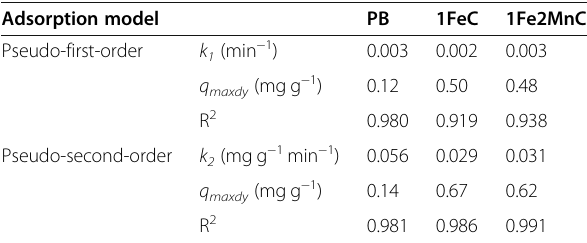
Table 5 The adsorption dynamics parameters of different models